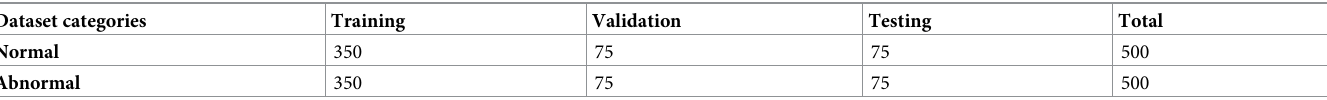
Table 1. Dataset